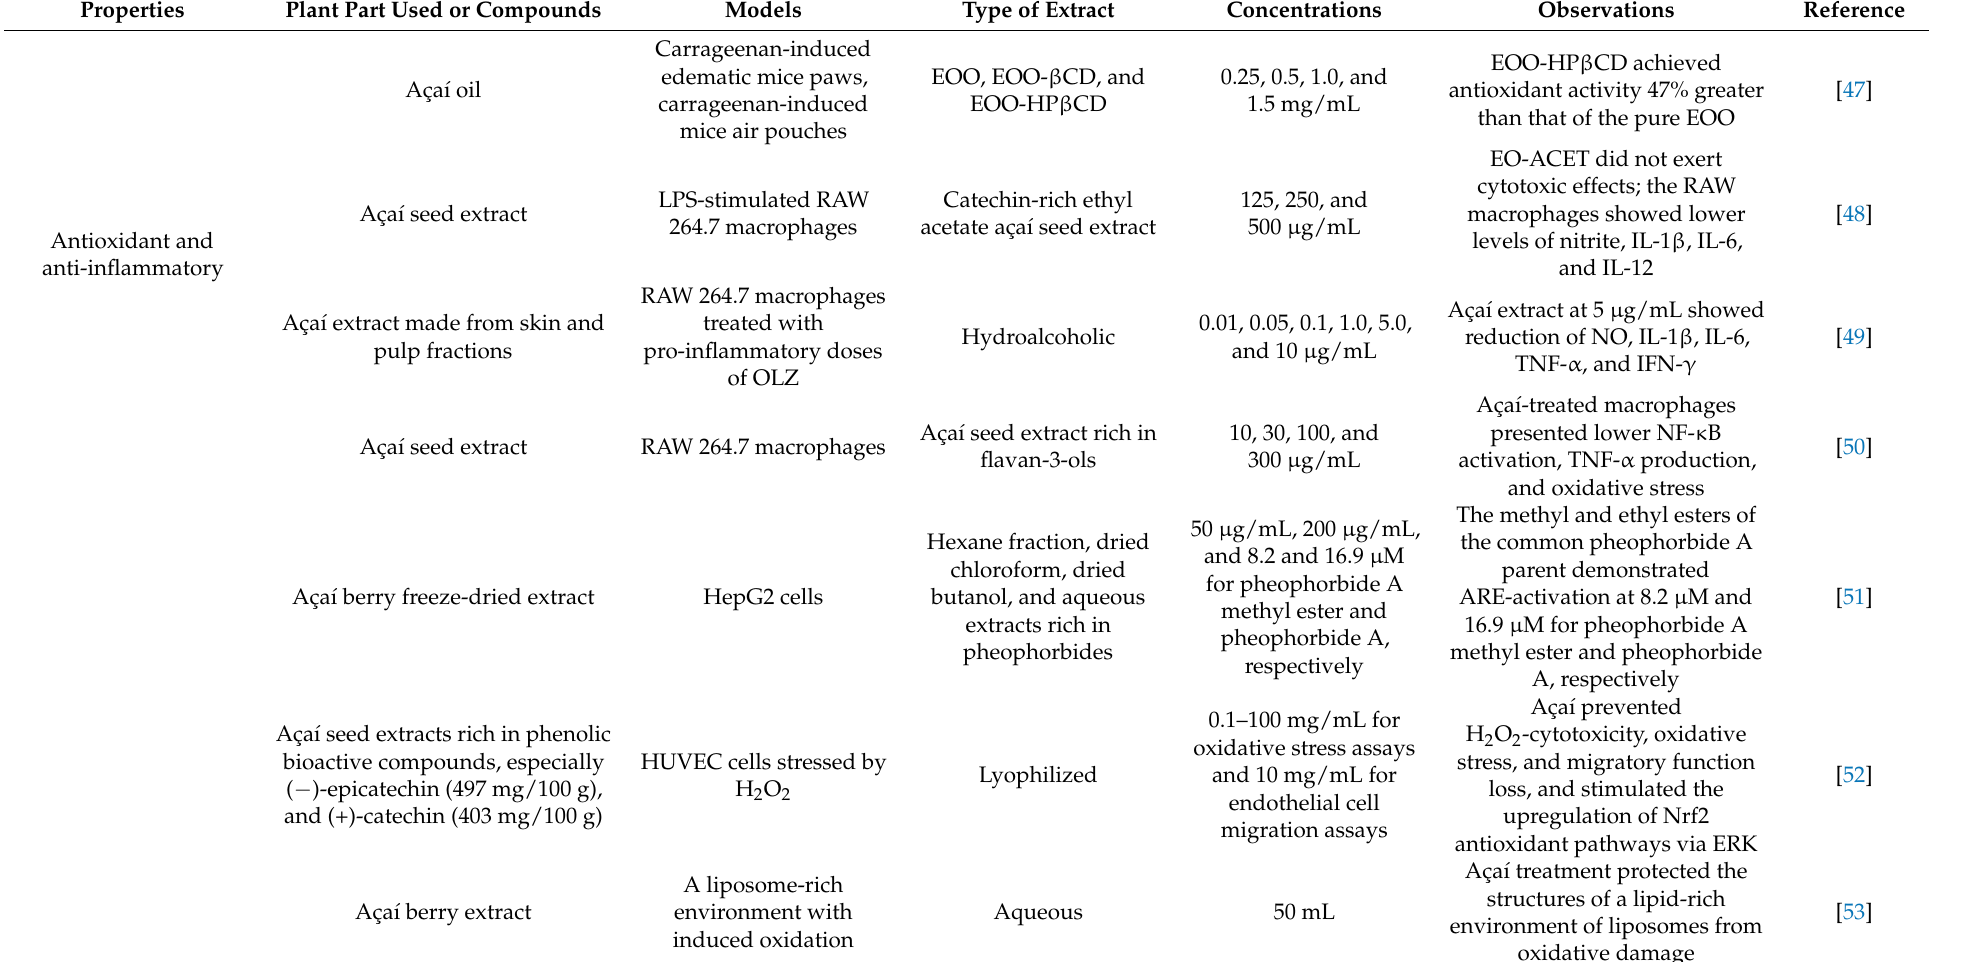
Table 1. In vitro biological and pharmacological activities of various extracts and pure compounds of aça í